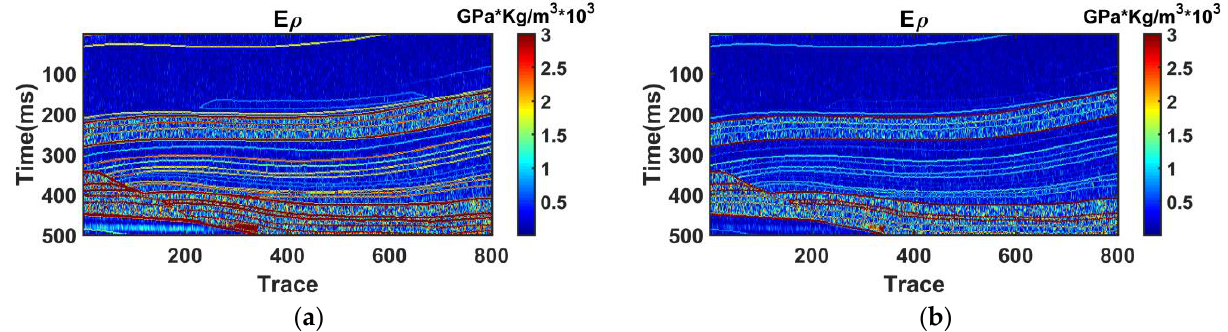
Figure 18. E ρ inversion error after adding noise based on ( a ) traditional method and ( b ) reweighted Lp method.